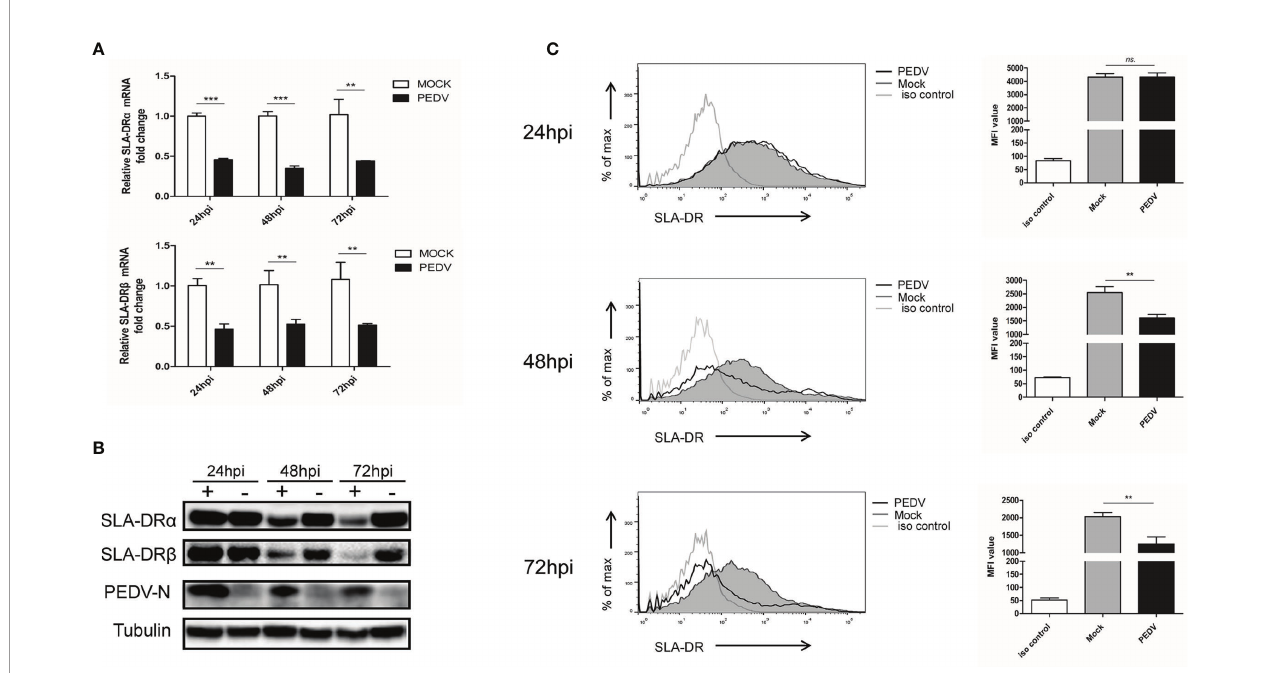
FIGURE 2 | PEDV replication inhibit expression of SLA-DR in BM-DCs (A) BM-DCs were infected by Vero cell-adapted PEDV strain KB2013-p120 at 1MOI for 24, 48 and 72 hours then harvested for qPCR analysis for mRNA level of SLA-DR a and SLA-DR b . Transcript of tubulin were analyzed from the same sample to normalize total RNA input. Error bars represent variation from at least three independent experiments. Signi fi cant differences between indicated groups was marked by ** P < 0.01; *** P < 0.001. (B) BM-DCs were infected by PEDV-KB2013-p120 strain at 1MOI for 24, 48 and 72 hours then harvested for western blot to evaluate SLA-DR a , SLA-DR b and PEDV-N protein level using corresponding antibodies. Normal BM-DCs cells without PEDV infection were included as control. Tubulin was probed from the same sample to normalize the total protein load. (C) BM-DCs were infected by PEDV-KB2013-p120 strain 1MOI for 24, 48 and 72 hours then stained with anti-SLA-DR antibody followed by visualization of APC labeled goat anti-mouse IgG. Then the cells were subjected to fl ow cytometry analysis for evaluating cell surface expression of SLA-DR. BM-DCs without PEDV infection stained with normal mouse IgG as primary antibody were included as primary antibody isotype control. Error bars represent variation of quanti fi cation of FACS data from at least three independent experiments. Signi fi cant differences between indicated groups was marked by ** P < 0.01; or ns, non signi fi cant.